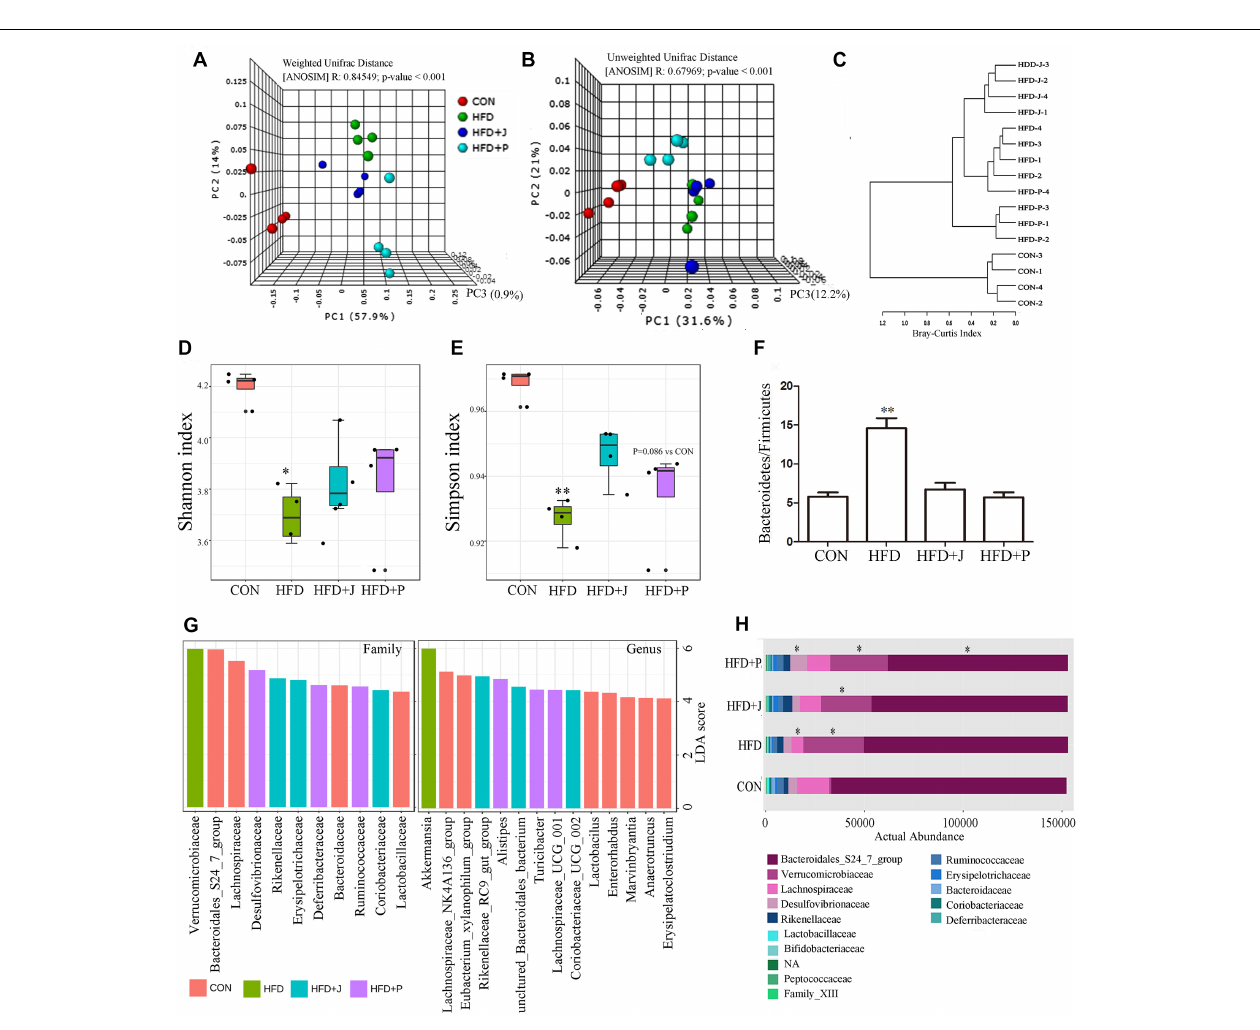
FIGURE 6 | Effect of Lactobacillus jensenii IgA-21 and Pediococcus acidilactici FS1 treatment on gut microbiota community structure after high-fat-diet feeding. (A) Microbial communities clustered using PCoA of the weighted UniFrac matrix. (B) Microbial communities clustered using PCoA of the unweighted UniFrac analysis. (C) Dendrogram of Hierarchical clustering analysis with distance measure based on Bray-Curtis index. (D) Evaluation of α Diversity by Shannan Index. (E) Evaluation of α Diversity by Simpson Index. (F) Ratio of Bacteroidetes to Firmicutes (G) Linear discriminant analysis (LDA) effect size (LEfSe) taxonomic cladogram based on 16S rRNA gene sequences on family and genus level (only LDA more 4 were listed). (H) Comparison of bacterial at family level. ∗ P < 0.05, ∗∗ P < 0.01 compare with CON; Comparisons were made with Kruskal-Wallis ANOVAs and the Bonferroni post hoc method to arrive at adjusted p -values. CON, control group; HFD, high-fat diet group; HFD + J, high-fat diet group treated with L. jensenii IgA-21; HFD + P, high-fat diet group treated with P. acidilactici